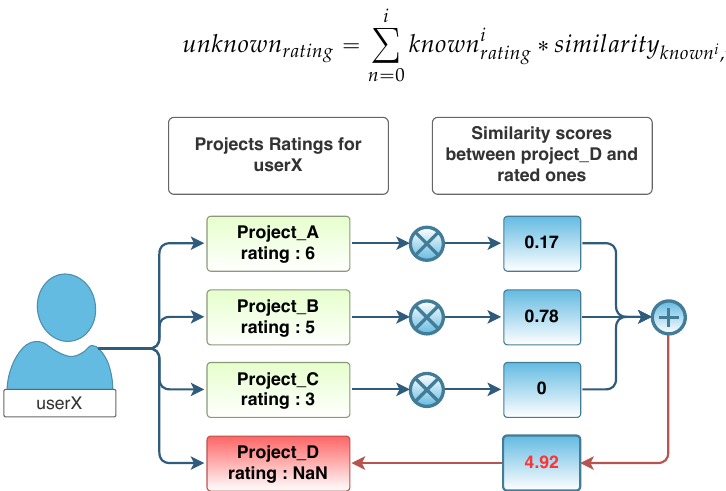
Figure 4. Calculating unrated project with the help of similarity rated